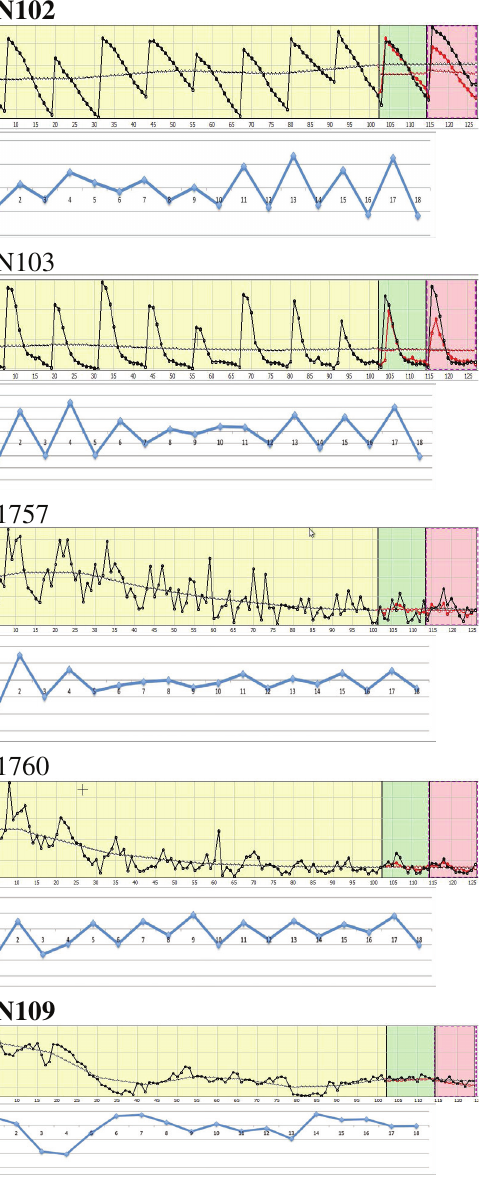
Figure 2: The time series chosen in the experiment. Each time series is depicted over the time domain T (cid:5) together with the estimated trend-cycle. The time domain T (cid:5) is divided into 3 parts: learning, validation and testing ones. Namely, T is divided into learning and validation part and T (cid:5) \ T is the testing part. The figure contains forecast of each time series over the testing part T (cid:5) \ T compared with the reality. Below each time series is depicted also the adjoint time series (21) over the time domain T (i.e., over learning and validation parts). The principal time series are marked in boldface